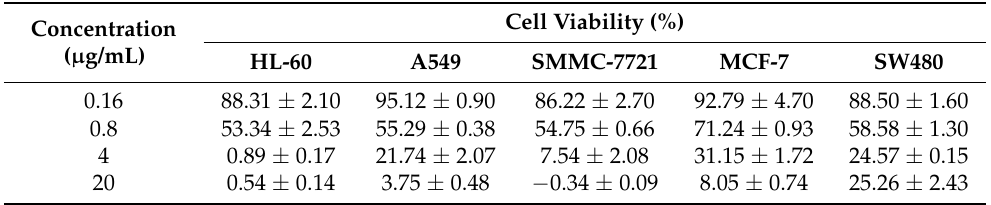
All data are represented as mean ± SD. n =